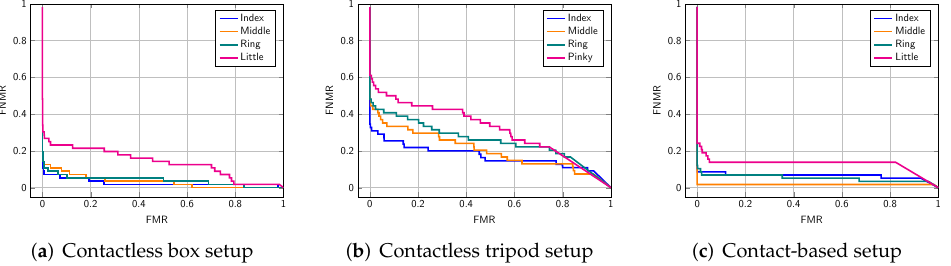
Figure 9. DET curves obtained from individual finger comparisons: index fingers (IDs 2, 7), middle fingers (IDs 3, 8), ring fingers (IDs 4, 9), and little fingers (IDs 5,